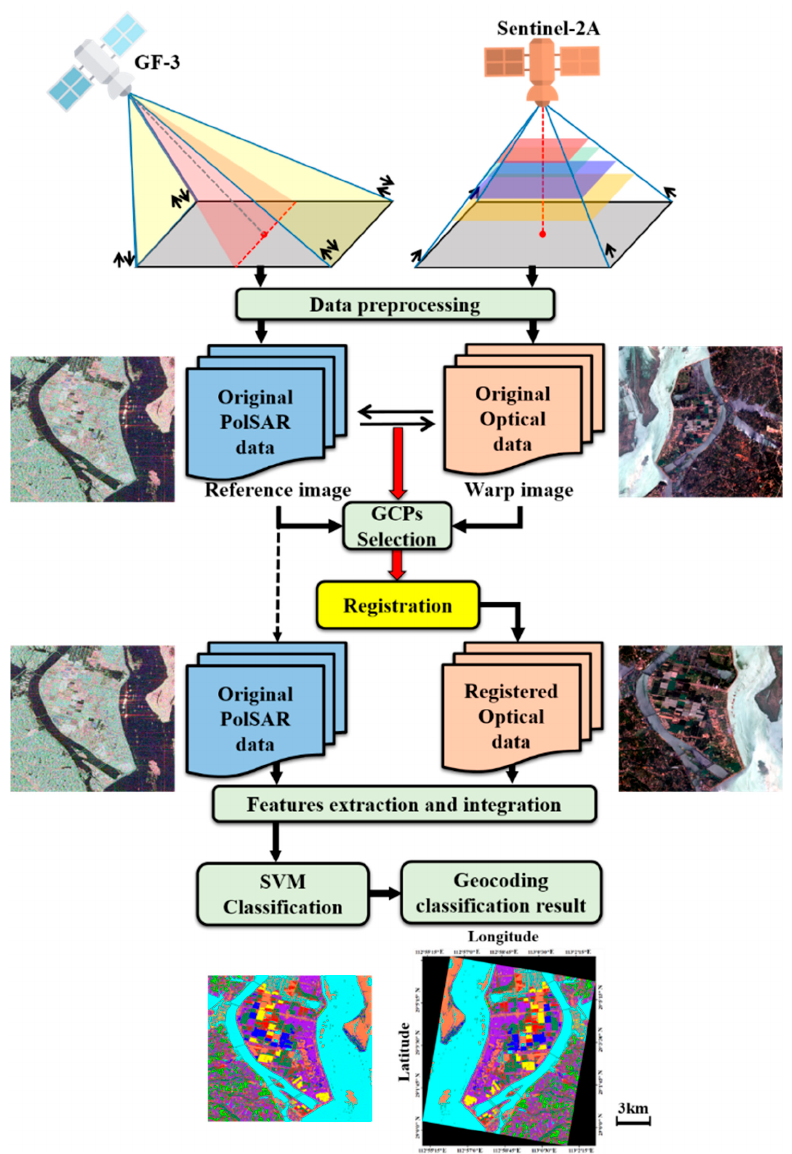
Figure 4. The registration process of the proposed method.